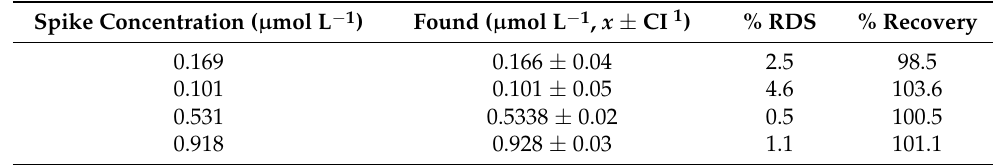
Table 4. Recovery experiments. Tap water samples adjusted to pH 5.5 with PBS and spiked with different MCPA